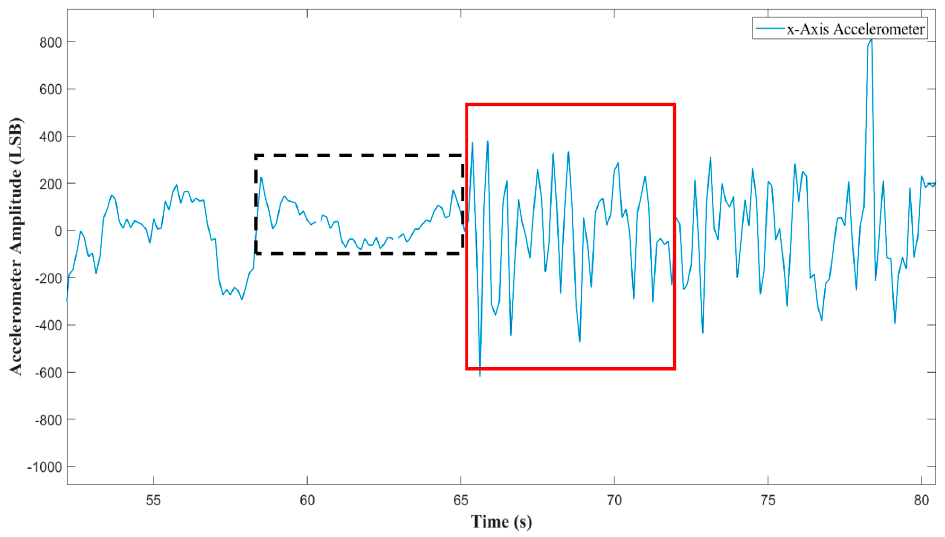
Figure 18. Mixed apnea morphology. Central (dashed black-line box) and obstructive (solid red) behavior.